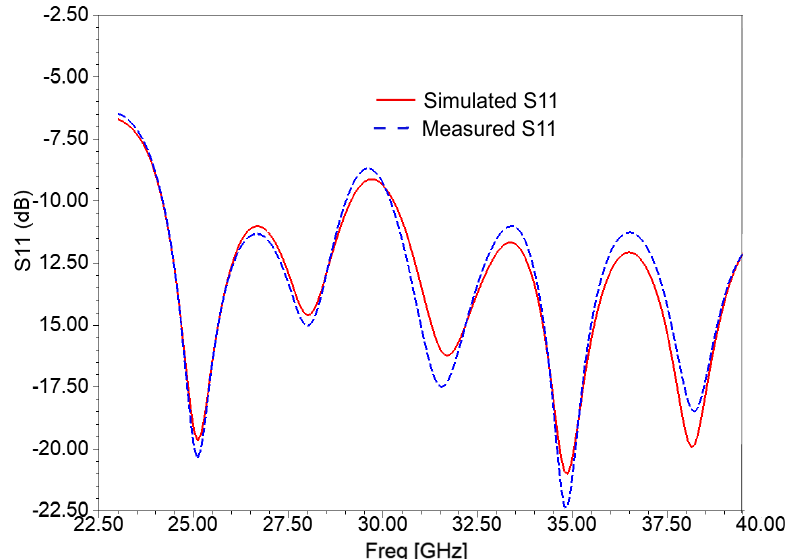
Figure 13. Simulated and measured S11 of the AVA array with